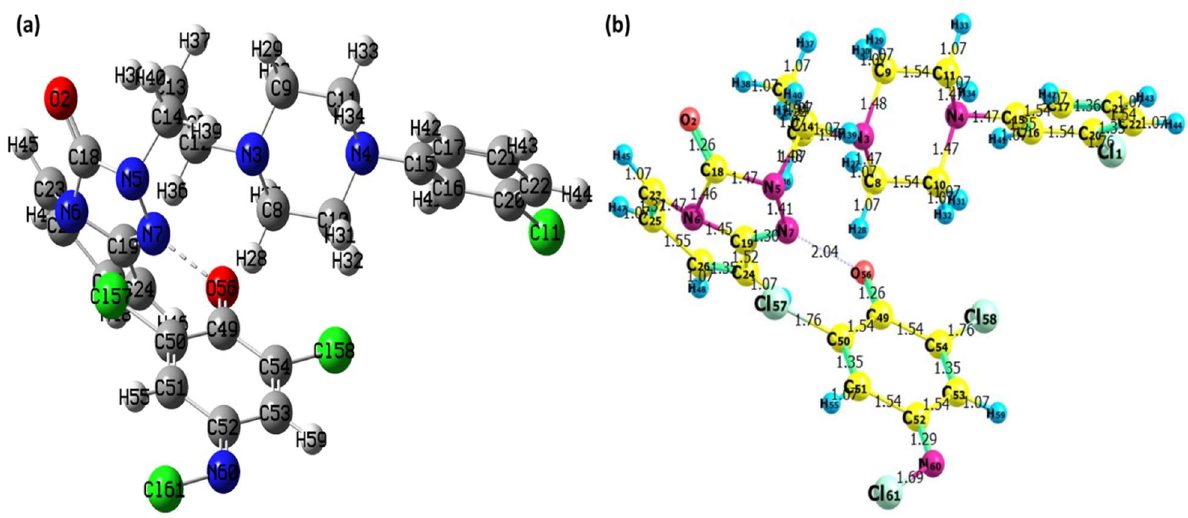
Figure 16. Optimized structure of the [(TZD)(DCQ)] complex; ( a ) Mulliken atom numbering scheme and ( b ) bond lengths.